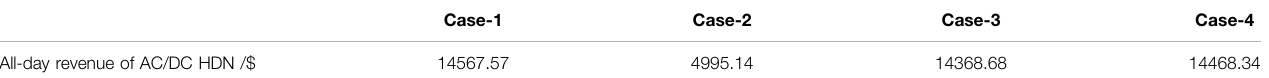
TABLE 4 | All-day revenue of AC/DC HDN under the four dispatch models